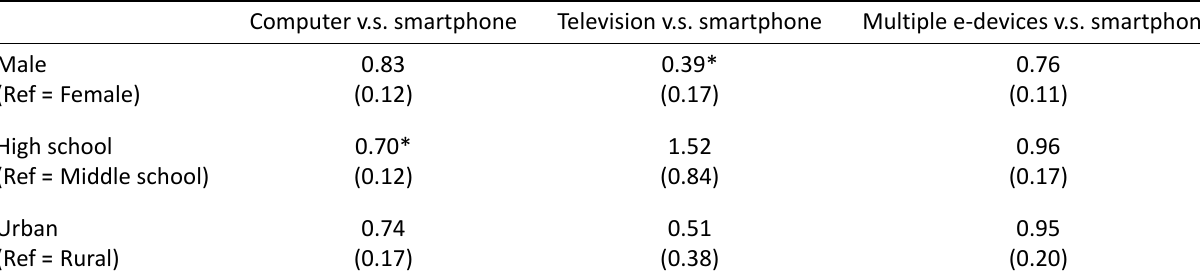
Table 3. Multinomial logistic regression results of respondent background characteristics on access to remote digital e‐ learning devices (N =